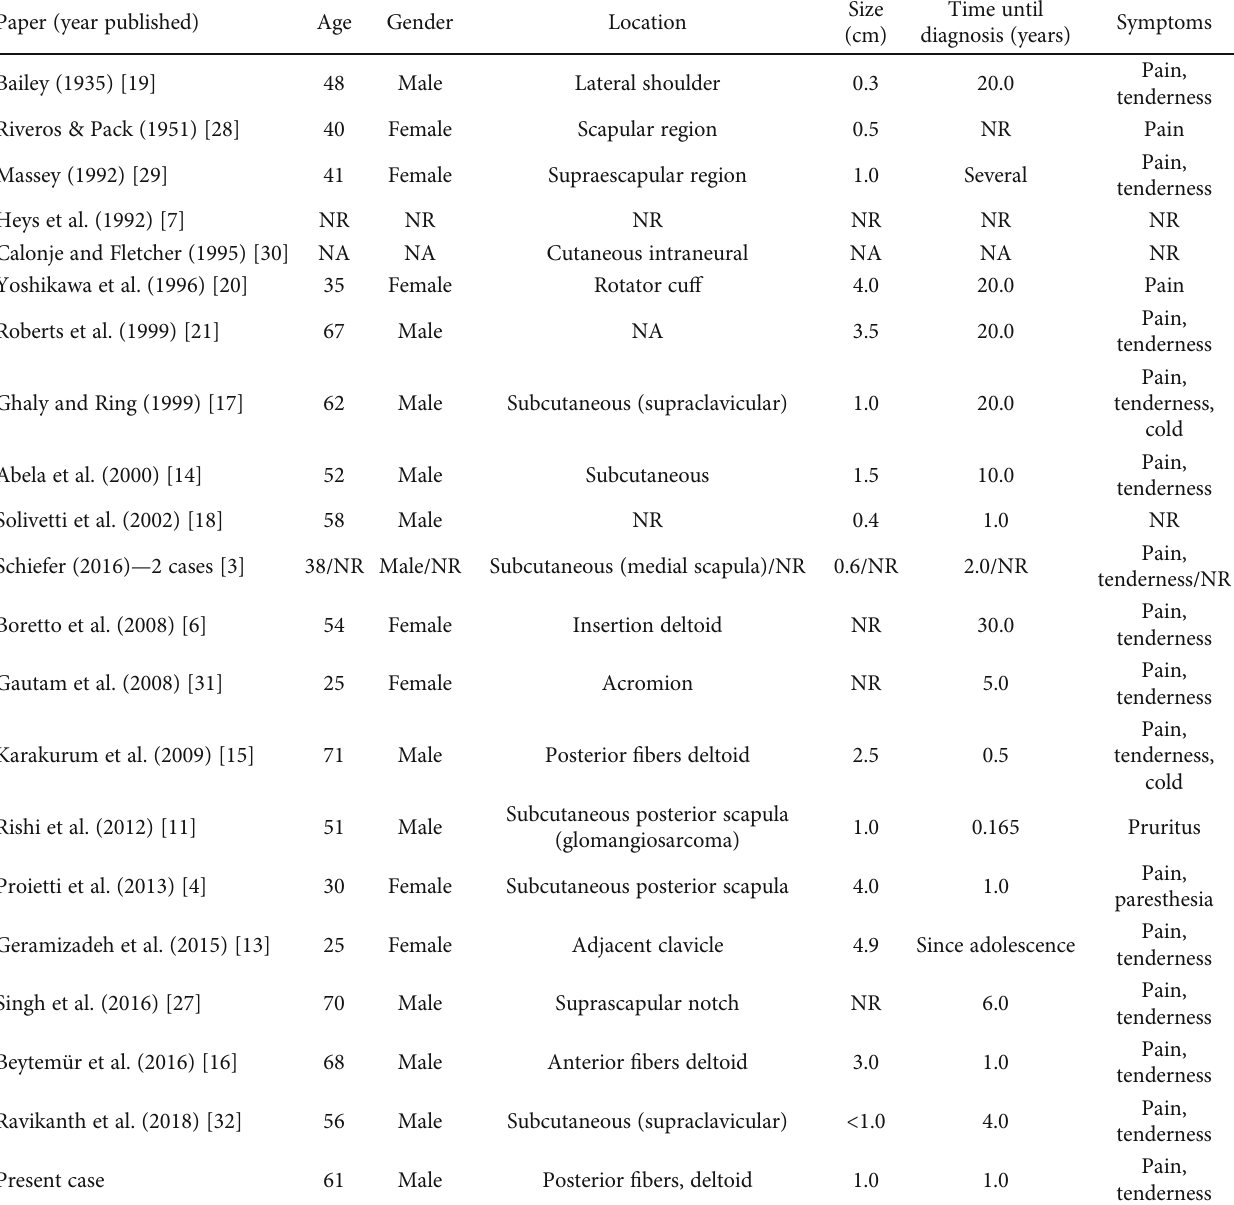
Table 1: Table compiling all cases of glomus tumors around the shoulder published in English literature. Paper (year